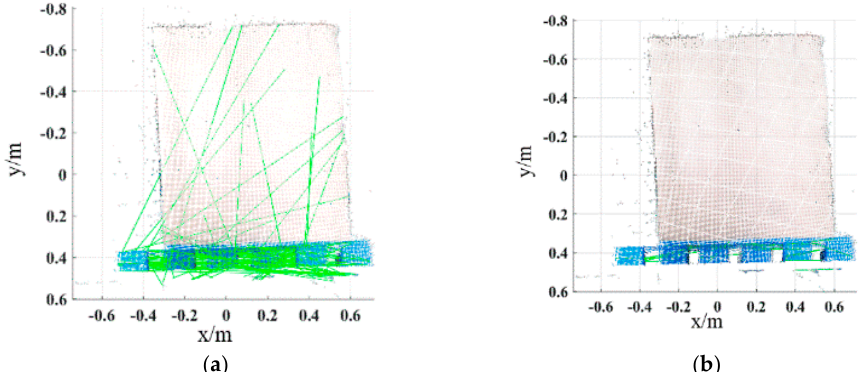
Figure 16. The result of feature matching. Schemes follow another format. ( a ) Feature matching. ( b ) Elimination of wrong matching point pairs. The green lines are the lines connecting the matching point pairs.